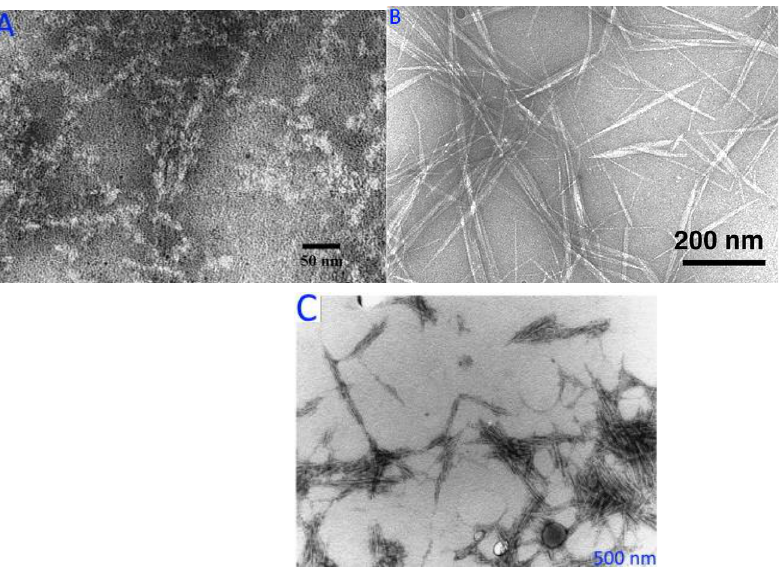
Figure 9. TEM images of ( A ) starch nanocrystals, ( B ) chitin nanocrystals, and ( C ) cellulose nanocrys- tals. Figure 7A – C reprinted with permission (copyright © 2023 Elsevier Ltd., Amsterdam, the Neth- erlands; copyright © 2023 American Chemical Society, Washington, USA; and copyright © 2023 Elsevier B.V., Amsterdam, the Netherlands) from Chen et al. [243], Fan et al. [244], and Neto et al. [245], respectively.